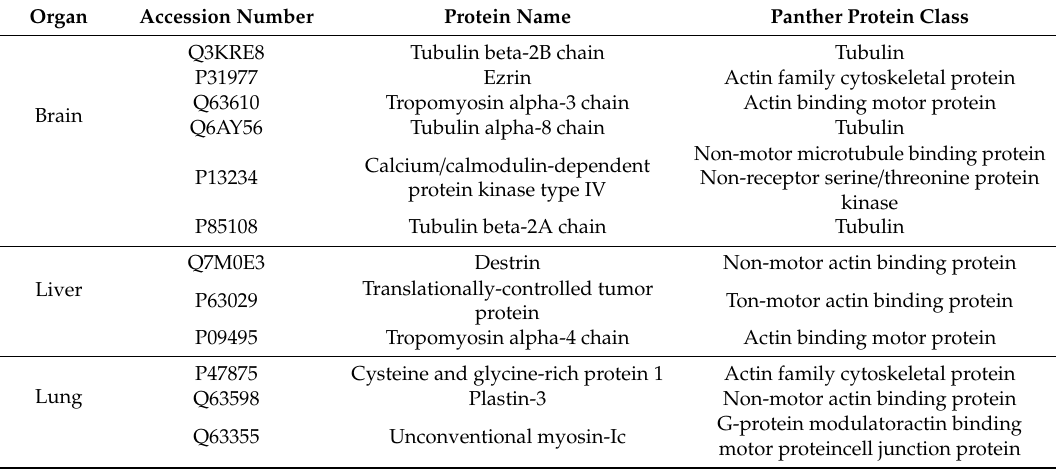
Table 7. List of the dysregulated cytoskeleton proteins in the brain, liver and lung following exposure to Iron